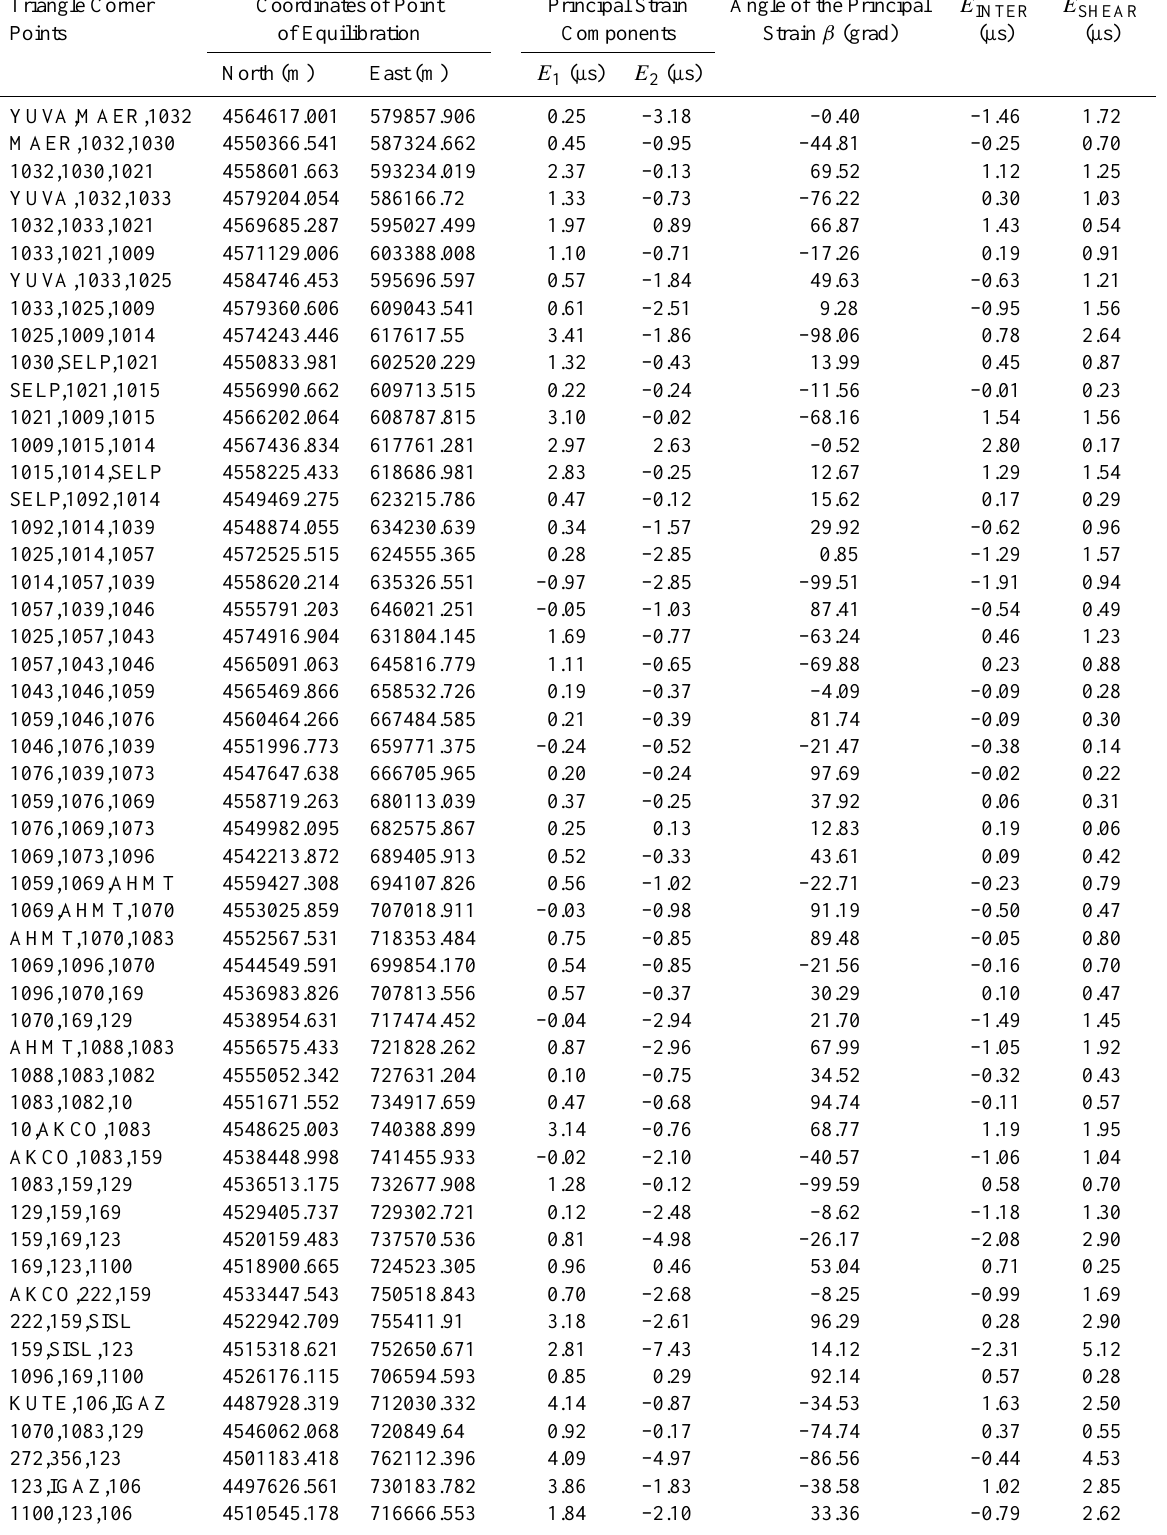
Table 5. Principal strain parameters computed for each triangle in the